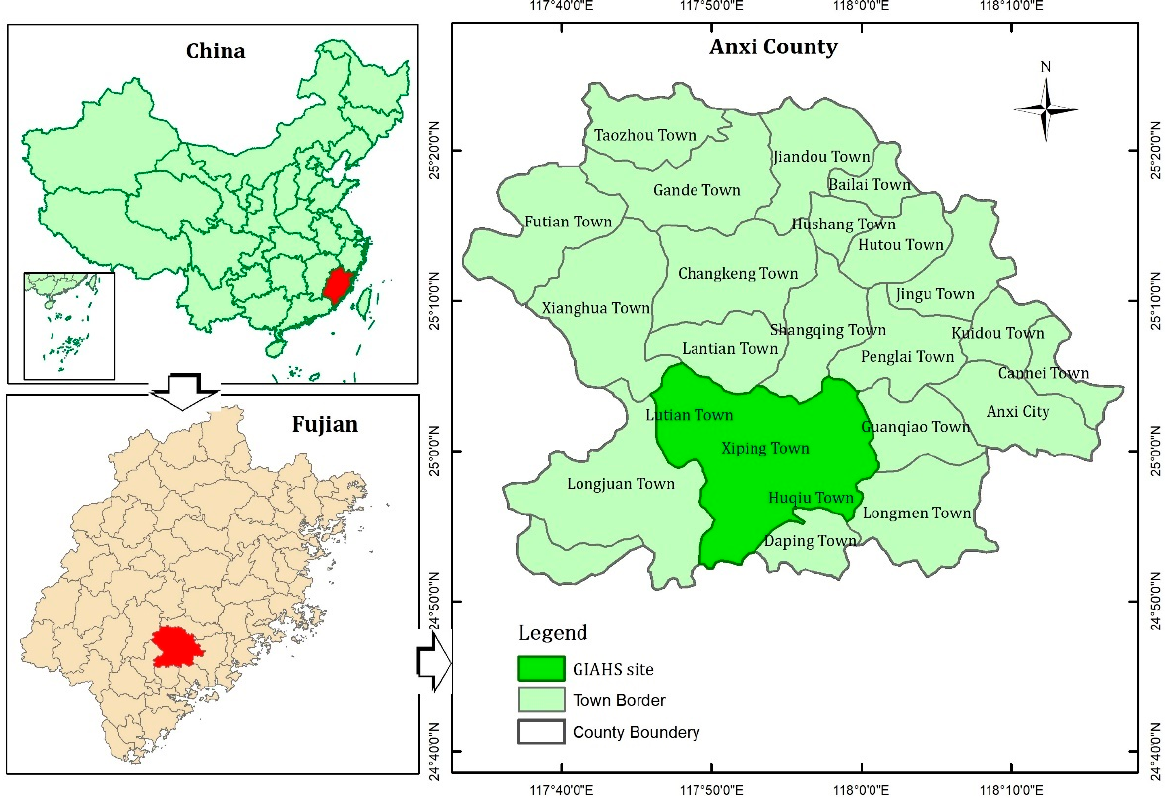
Figure 4. Location of Anxi County and scope of the GIAHS sites.